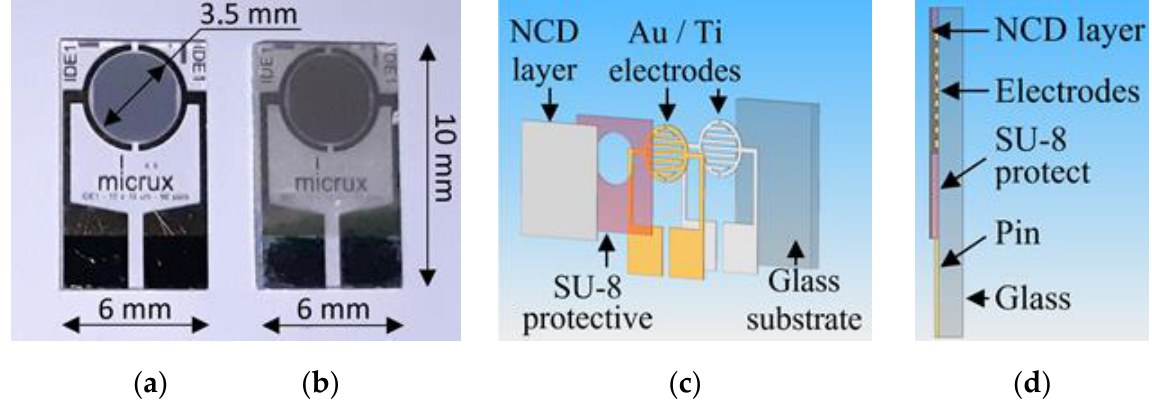
Figure 5. Photographs of ( a ) IDT structure on a glass substrate and ( b ) sensor with NCD active layer, ( c ) exploded schematic view, and ( d ) schematic cross-section.